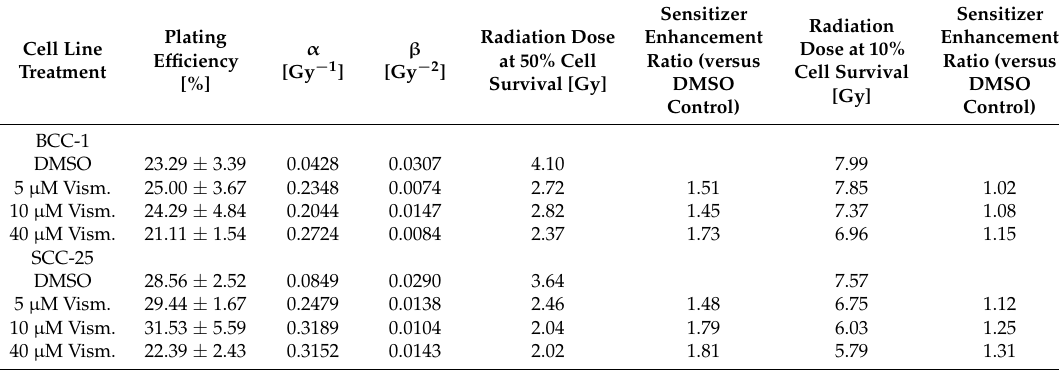
Table 1. Radiation response variables of vismodegib-treated BCC-1 and SCC-25